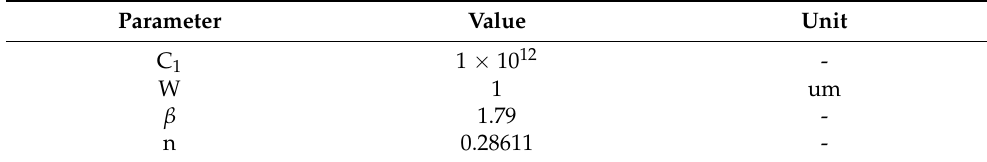
Table 2. Parameters of HCI model during simulation.